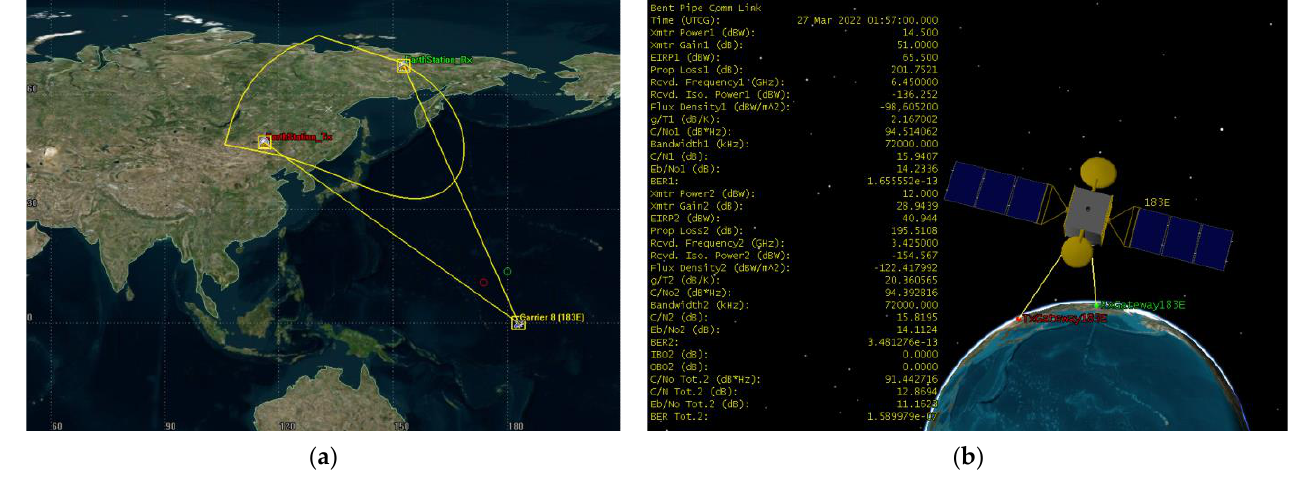
Figure 7. Scenario 1 operation ( a ) 183° E bent pipe transponder operation ( b ) Bent piper of Yamal 183E transponder composite link calculation.